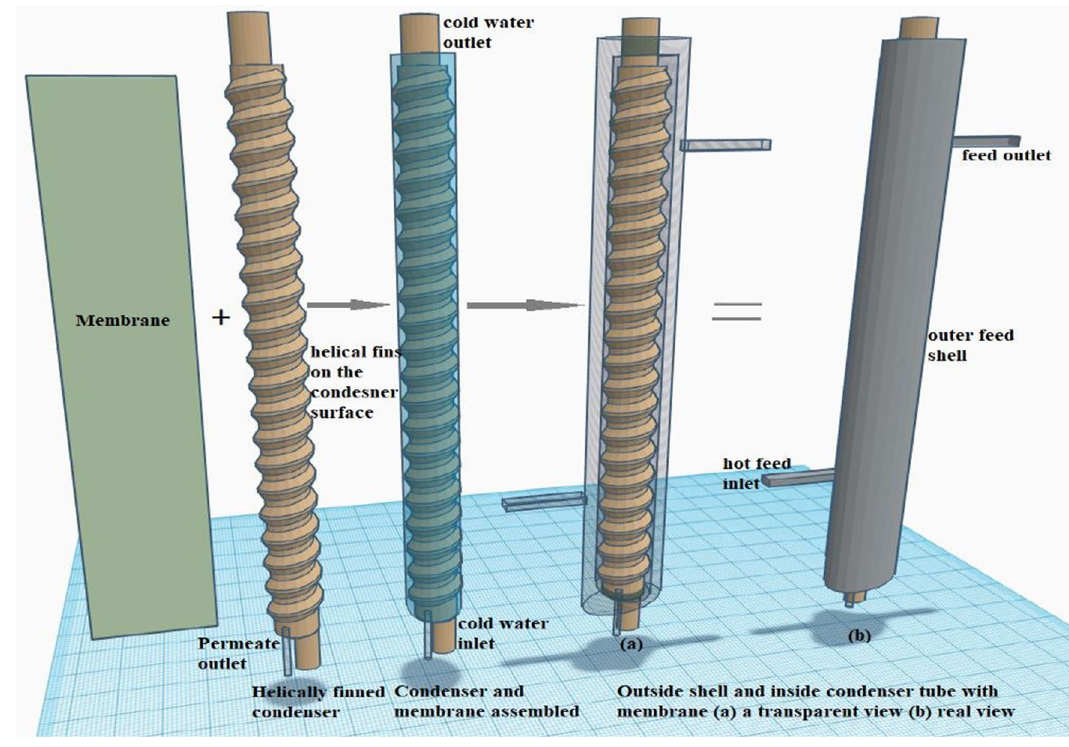
Fig. 1 Components and assembly details of HAGMD